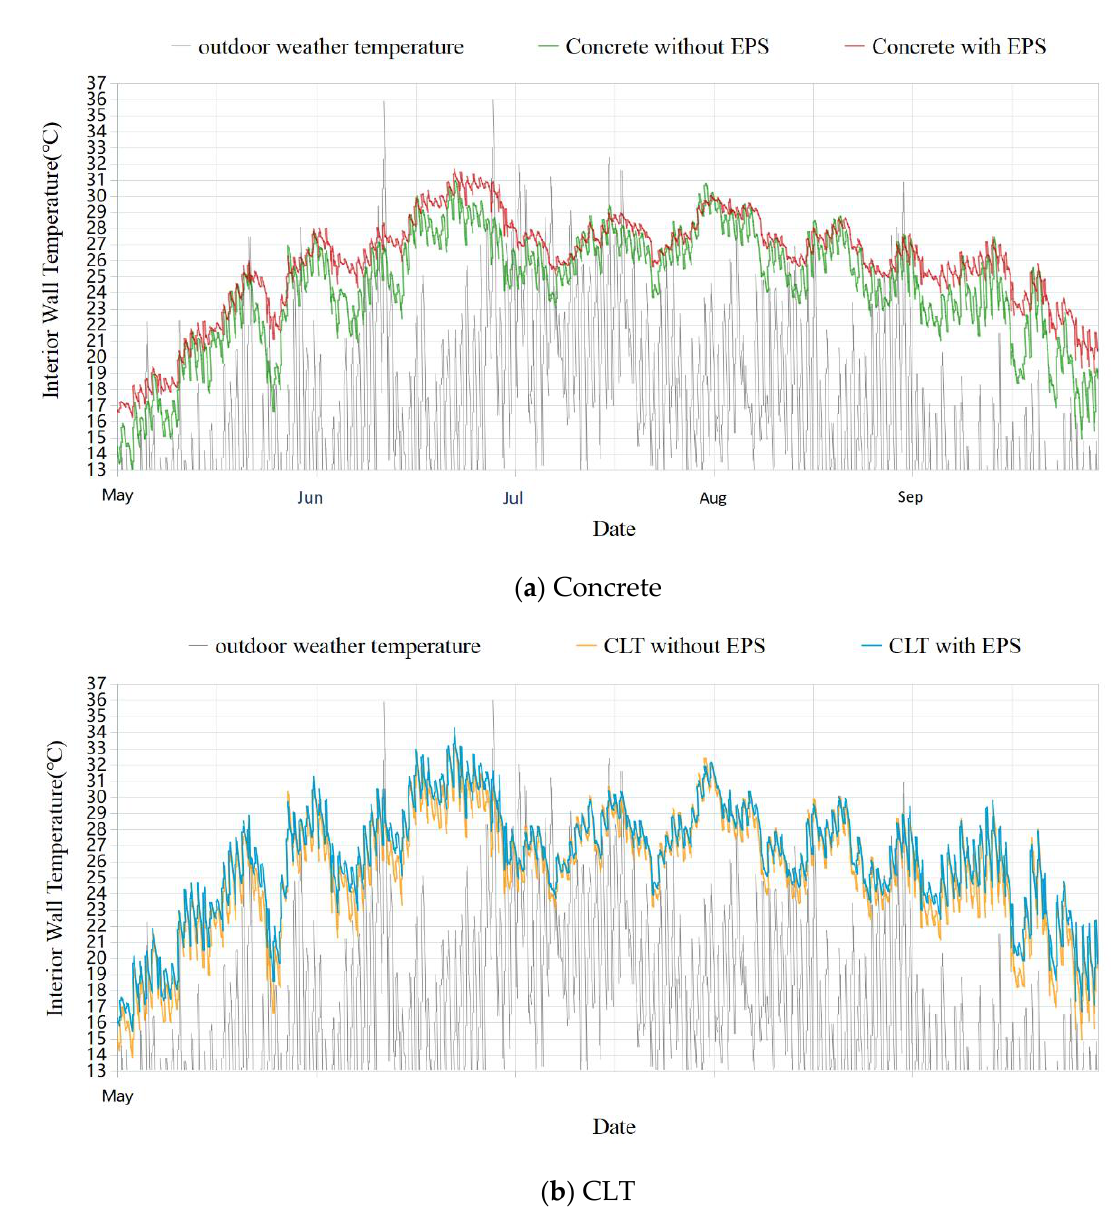
Figure 12. Comparison of interior wall surface temperatures for different construction materials with and without insulation during May to September in Harbin.